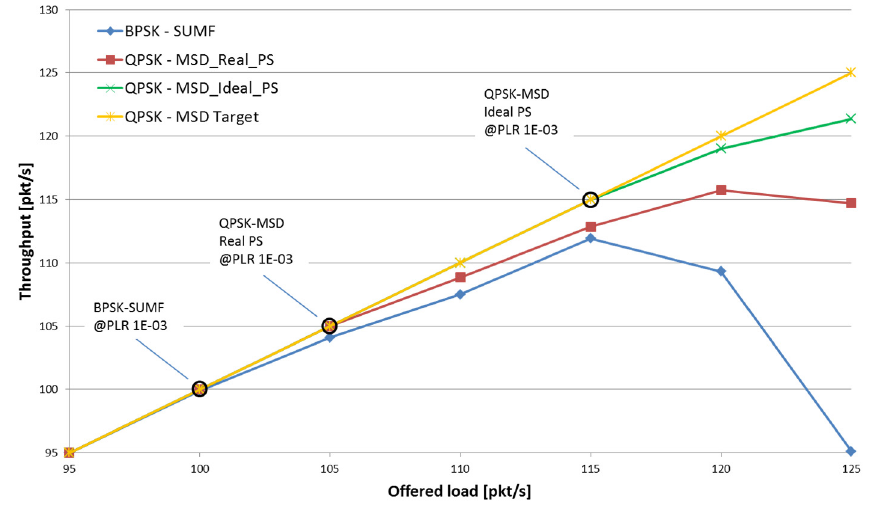
Figure 13. Comparison of Ideal PS vs. Real PS.